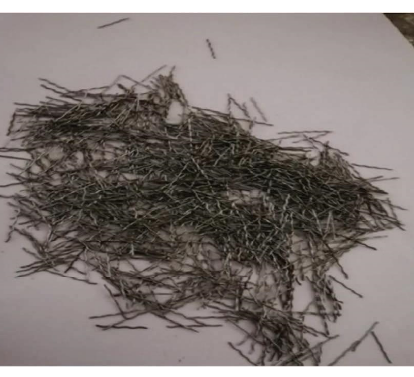
Figure 3: Crimped steel fbres.